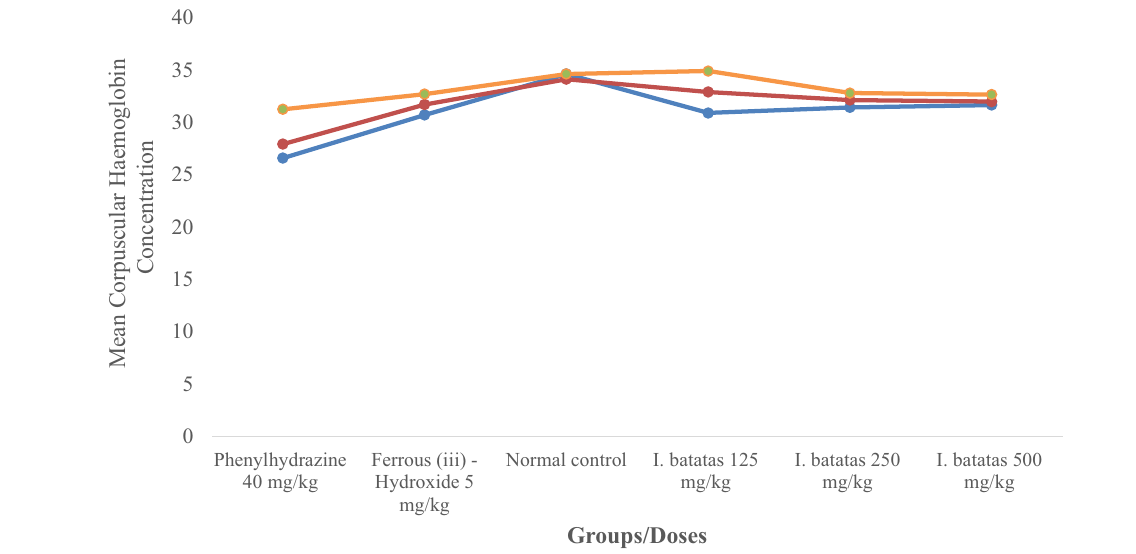
Fig. 6 Effect of Ipomoea batatas L . n-Hexane leaves extract on mean corpuscular haemoglobin concentration in phenylhydrazine-induced anaemic rats. Blue—day 1, red—day 7, orange—day 14